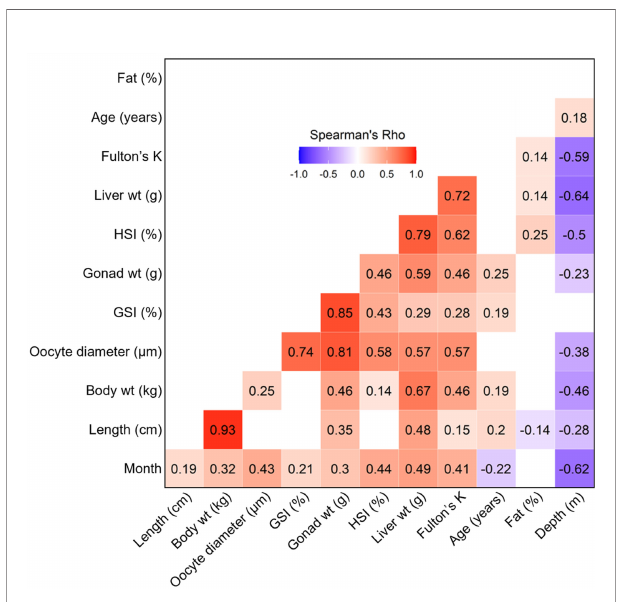
FIGURE 7 | Spearman ’ s correlations of biological indices for all statistically signi fi cant comparisons (p < 0.05). Direction of correlation is mapped with red (positive) and blue (negative) color scheme, and magnitude of correlation is shown from lighter tints (weak) to dark (strong).